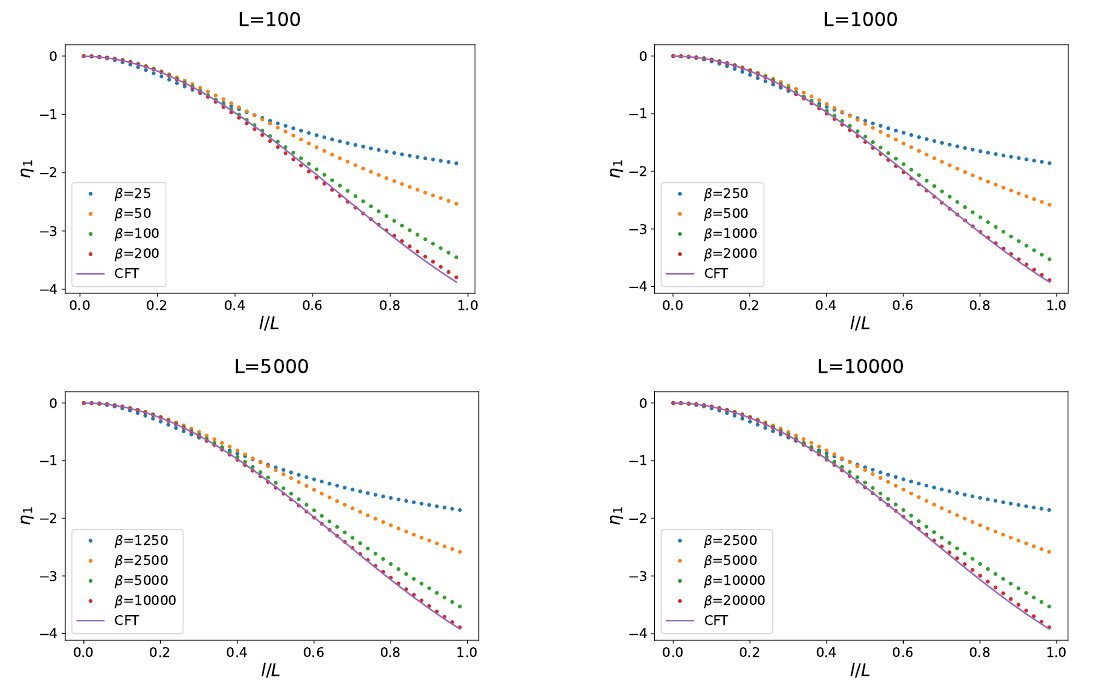
Figure 1 . Numerical test of the thermal correction parameter η 1 for the total number of grids N = 100 , 1000 , 5000 and 10000 . β/L is fixed at 0 . 25 , 0 . 5 , 1 and 2 in each case. The continuous curve is the CFT prediction in eq. (3.4).